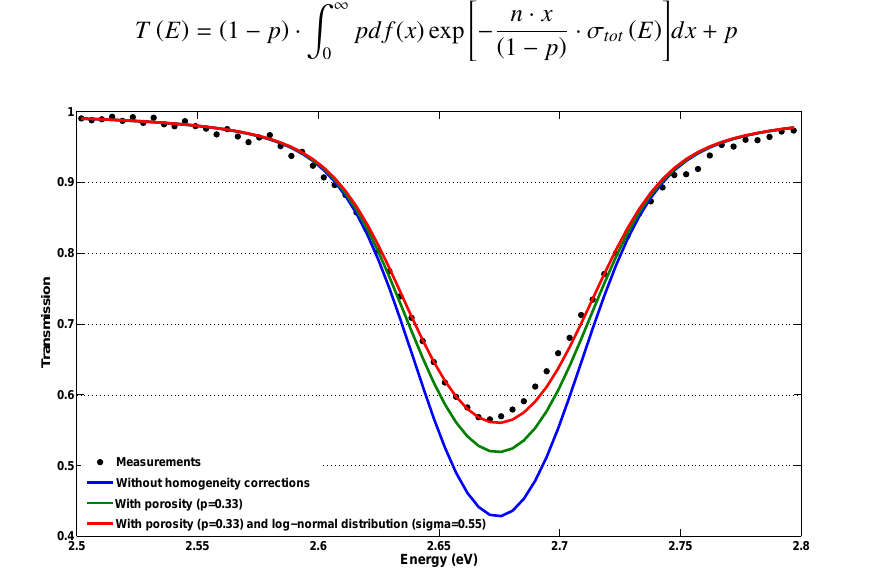
Figure 5. Sample homogeneity corrections on 242 Pu transmission